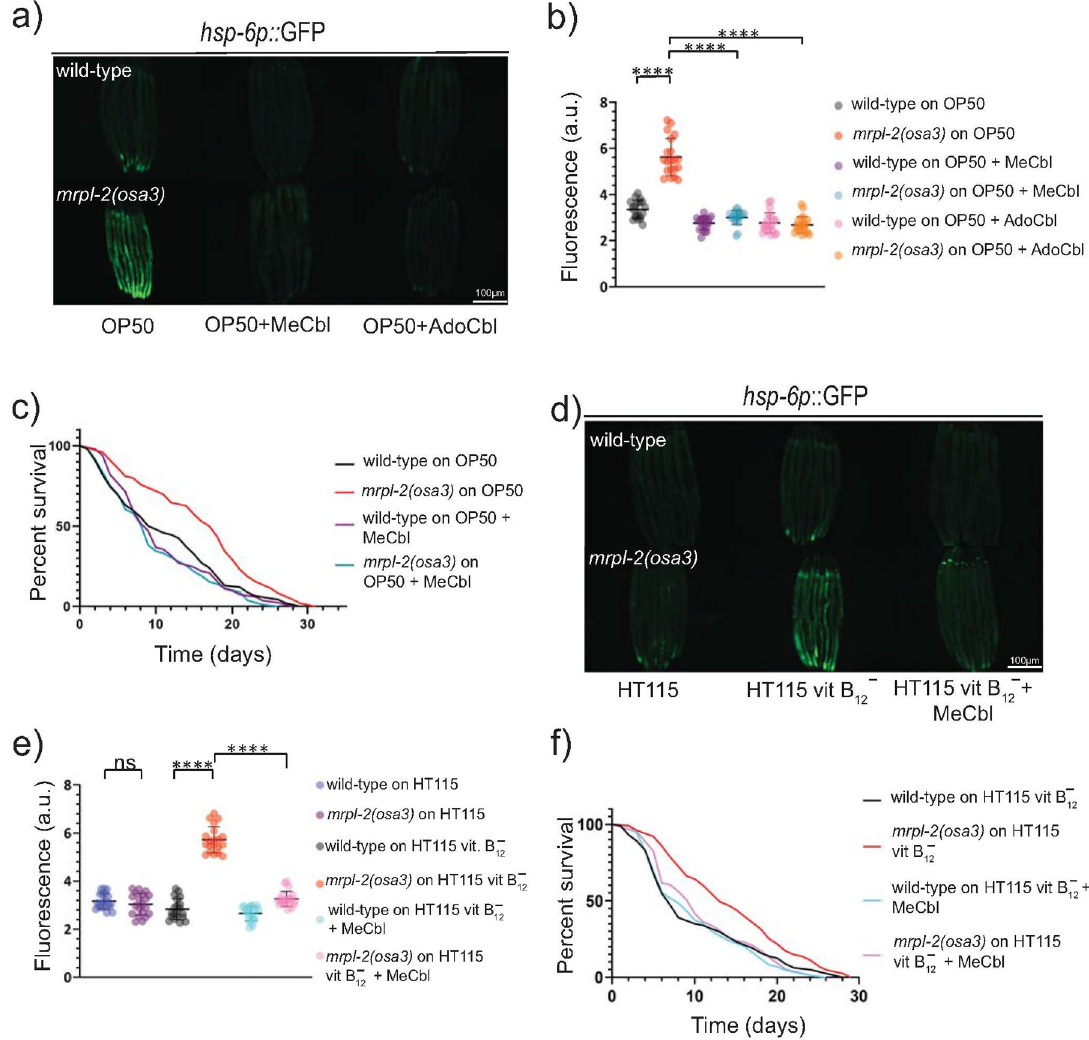
Fig 5. Vitamin B12 levels determine the activation of the UPR mt in mrpl-2(osa3) animals under different diets. (A, B) Photomicrographs and quantification of hsp-6p ::GFP expression in wild-type and mrpl-2(osa3) animals fed E . coli OP50 in the presence or absence of 0.2 μ g/ml methylcobalamin or adenosylcobalamin. Quantification of fluorescence intensities expressed as arbitrary units (A.U.); (mean ± SD; n � 20 worms); ���� denotes p � 0.0001 (Student’s t test). (C) Lifespans of wild-type and mrpl-2(osa3) animals fed E . coli OP50 in the presence or absence of 0.2 μ g/ml methylcobalamin. (D, E) Photomicrographs and quantification of hsp-6p ::GFP expression in wild-type and mrpl-2(osa3) animals fed vitamin B12-restricted E . coli HT115 in the presence or absence of 0.2 μ g/ml methylcobalamin. Quantification of fluorescence intensities expressed as arbitrary units (A.U.); (mean ± SD; n � 20); ns denotes not significant, ���� denotes p � 0.0001 (Student’s t test). (F) Lifespans of wild-type and mrpl-2(osa3) animals fed vitamin B12-restricted E . coli HT115 in the presence or absence of 0.2 μ g/ml